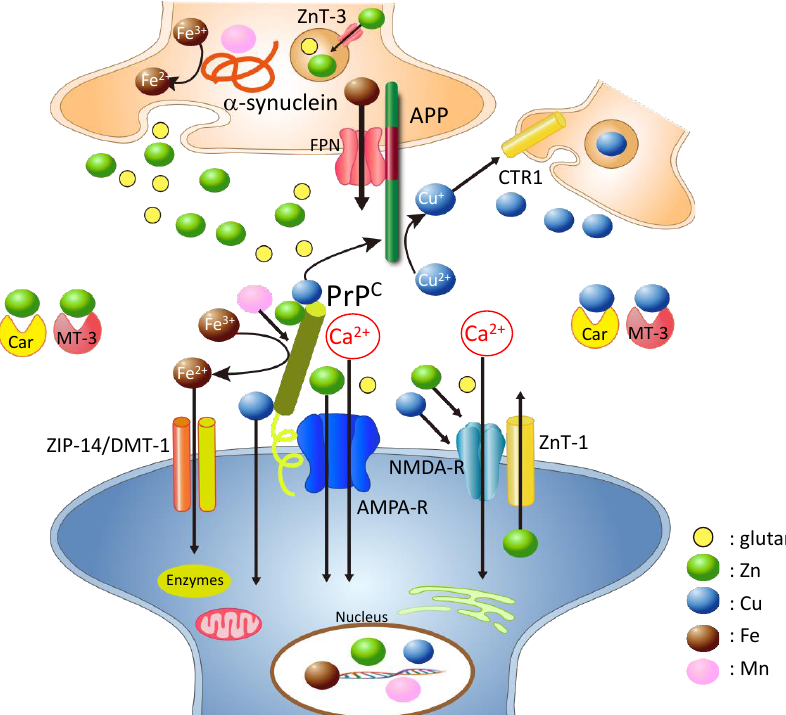
Figure 2. Hypothetical scheme: loss of normal functions of amyloidogenic proteins at the synapse. Normal cellular prion protein (PrP C ) is located in the postsynaptic membrane and binds to various receptors. PrP C binds to copper (Cu), zinc (Zn), and iron (Fe) and regulates their levels at the synapse. Additionally, PrP C acts as a ZIP Zn transporter analogue, and the ZnT-1 Zn transporter is also localized at postsynaptic membranes; both proteins control Zn levels at the synapse. PrP C can provide Cu to amyloid precursor protein (APP) or other Cu-binding proteins at the synapse. APP is mainly localized at the presynaptic membrane, binds to Cu and/or Zn, and has the ability to convert Cu 2+ to Cu + . APP also regulates Fe 2+ efflux from cells via ferroportin. α-Synuclein is mainly localized at the presynaptic domain and binds Cu, manganese (Mn), and Fe. Both PrP C and α-synuclein have ferrireductase activity and provide bioavailable Fe 2+ to enzymes at the pre- and postsynaptic regions, respectively. Fe 2+ is transported into cells by the ZIP-14 and DMT-1 complex. Other metal-bind- ing factors such as MT-3 and carnosine (Car) are secreted into the synaptic cleft and play critical roles in the maintenance of metal homeostasis. NMDA-R; NMDA-type glutamate receptor, AMPA-R; AMPA-type glutamate receptor, FPN: ferro- portin; colored circles represent glutamate, Zn, Cu, Fe, and Mn. Since an excess of Zn 2+ is neurotoxic, ZnT-1 and PrP C , an analogue of the ZIP trans- porter, contribute to maintaining the synaptic Zn 2+ level. Furthermore, PrP C binds to Cu 2+ , regulates the intracellular Cu level, and provides synaptic Cu 2+ to APP or other Cu-bind- ing proteins. PrP C influences AβP production by regulating the Cu 2+ level. APP binds to Cu 2+ , reduces it to Cu + , and may provide Cu + to CTR1, which passes Cu + and functions in the intracellular accumulation of Cu [77]. Both APP and PrP C contribute to the regulation of Cu levels in the presynaptic and postsynaptic regions, respectively. α-Synuclein also controls the Cu and Mn levels in the presynaptic domains. PrP C acts as a ferrireductase to convert Fe 3+ to Fe 2+ in the postsynaptic domain and regulates Fe 2+ influx through the DMT1 and ZIP14 complex. Meanwhile, α-synuclein acts as a ferrireductase in the presynaptic